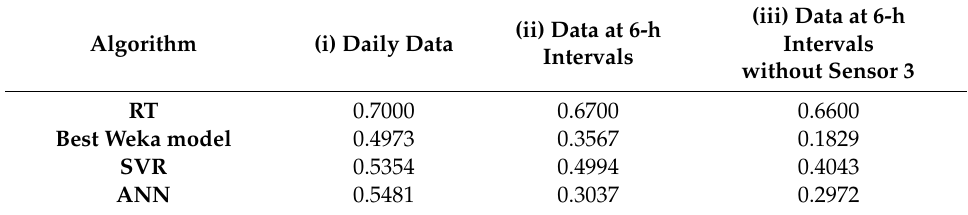
Table 2. Root-mean-squared error (RMSE) in mm / day, for the prediction of the daily ETo using the di ff erent regression algorithms on the three datasets defined. RT: regression tree; SVR: support vector regression; ANN: artificial neural